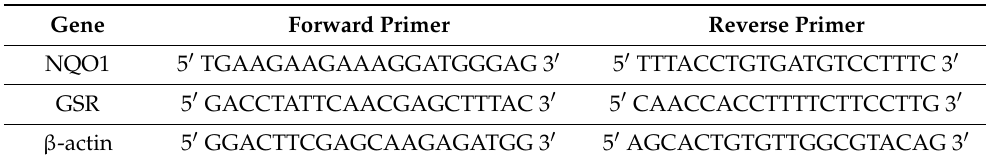
Table 1. Primer sequences. Table containing the forward and reverse primer sequences for NQO1, GSR, and β